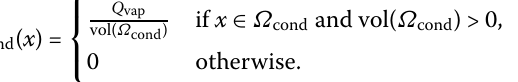
( T ) of tissue water density from dT